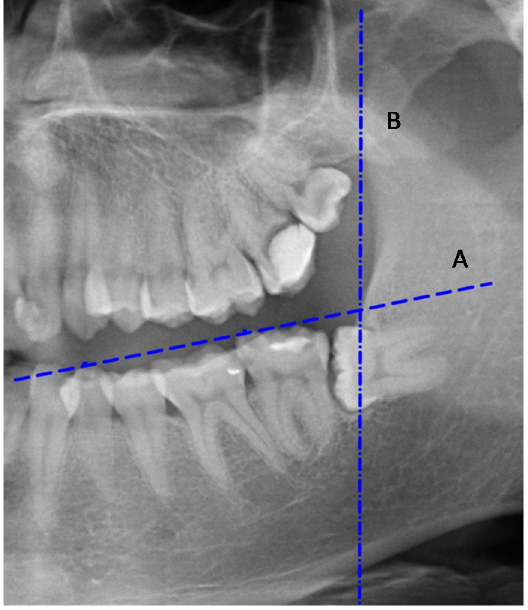
Figure 1. The occlusal plane line ( A ) and the mandibular anterior ramus line ( B ). The mandibular ramus anterior margin line (B) is a line tangent to, and parallel to, the greatest concavity of the mandibular ramus anterior margin [14] (Figure 1).